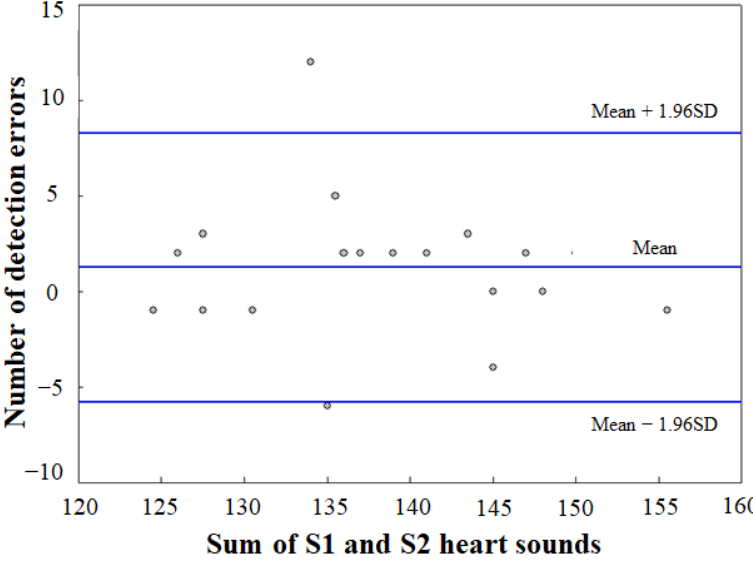
Figure 12. Bland-Altman plot for analysis of detected heart sounds using envelogram approach.